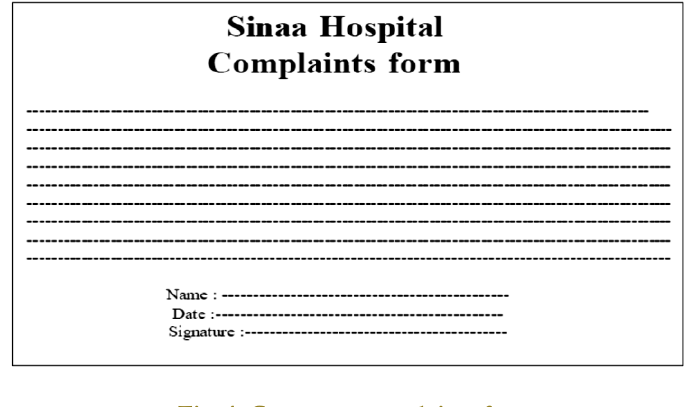
Fig. 1. Customer complaints form.